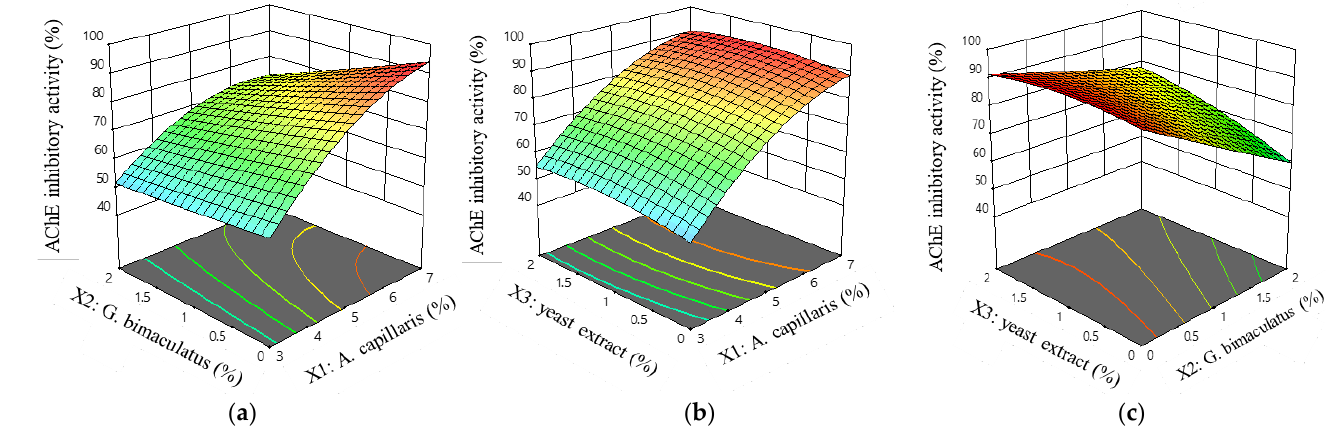
Figure 3. Response surface and contour plots for the AChE inhibitory activity of MKJW-fermented A. capillaris . A. capillaris and G. bimaculatus ( a ); A. capillaris and yeast extract ( b ); G. bimaculatus and yeast extract ( c ).